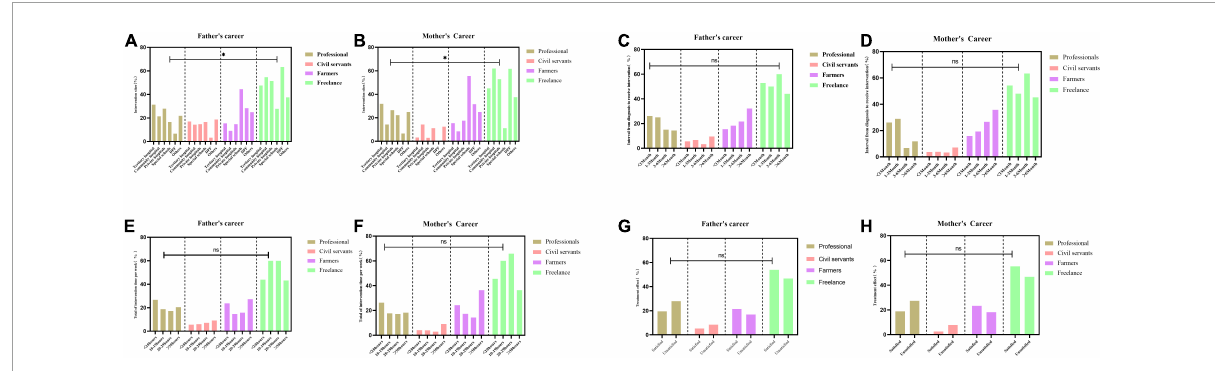
FIGURE1 Influence of parental occupation on the intervention status of children with autism spectrum disorder (ASD), (A,B) for the choice of rehabilitation institutions, (C,D) for the interval from diagnosis to receiving intervention, (E,F) for the total duration of the intervention per week, (G,H) for satisfaction with the intervention effect. * p < 0.05; ns, p > 0.05.